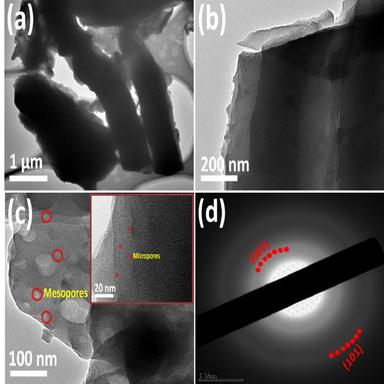
(a-c) HR-TEM images at different magnifications and (d) SAED pattern of the as-prepared TWPC sample.